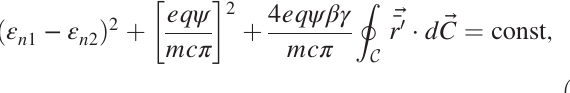
FIG. 5. (a) Horizontal/vertical beam size (red/blue) and beam rms-area (green) along the beam line. (b) Summands of Eq. (23) and their sum along the beam line. Results from tracking (application of the generalized Courant-Snyder formalism) are plotted in solid